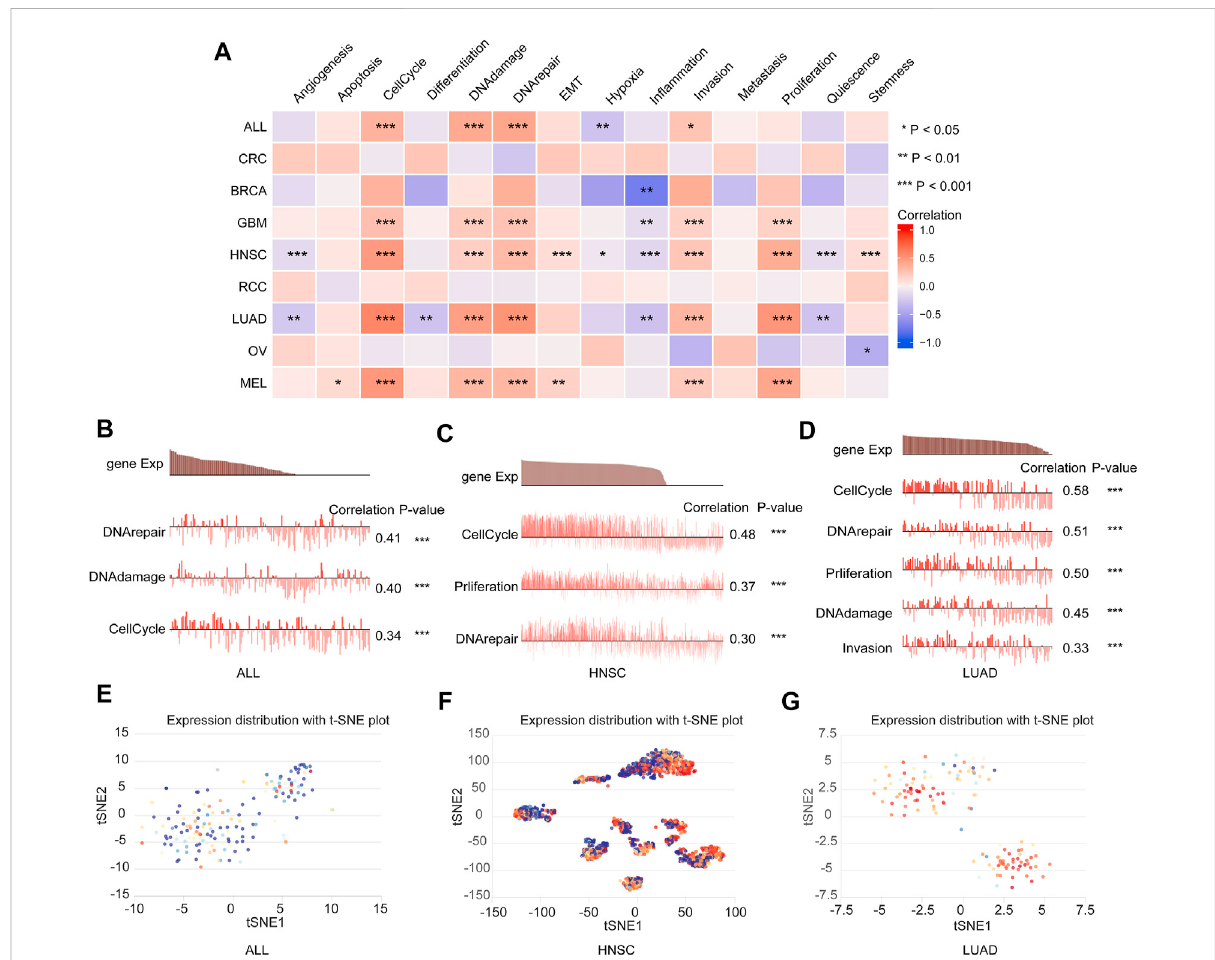
FIGURE 11 DTYMKexpressionandcancerfunctionalstatesatasingle-celllevel. (A) DTYMKexpressionwascorrelatedwithcancerfunctionalstatesinpan- cancer. (B – D) The association between DTYMK expression and cancer function in ALL, HNSC, and LUAD. (E – G) The t-SNE plot indicated DTYMK expression pro fi le in single cells of ALL, HNSC, and LUAD. (ns, no signi fi cant; *, p < 0.05, **, p < 0.01, ***, p <